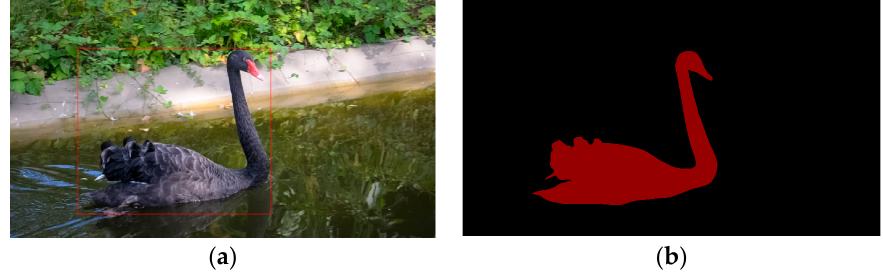
Figure 1. ( a ) Object labeled with rectangular box; ( b ) object labeled with